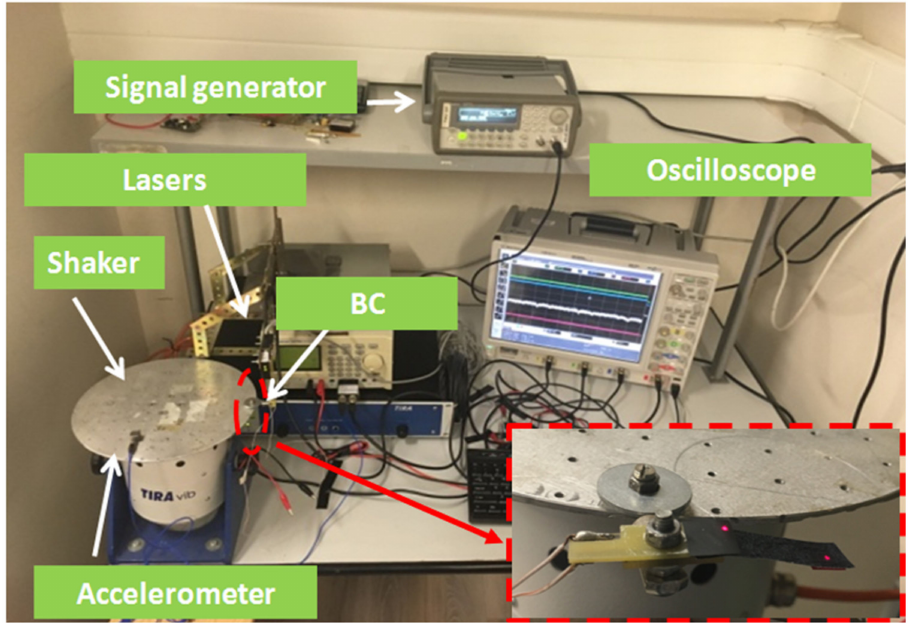
Figure 8. Experimental setup for the characterization of the BC-IL-based accelerometer (~34.4 mm long and ~10.6 mm wide). The inset shows a view of the accelerometer, mounted in the cantilever